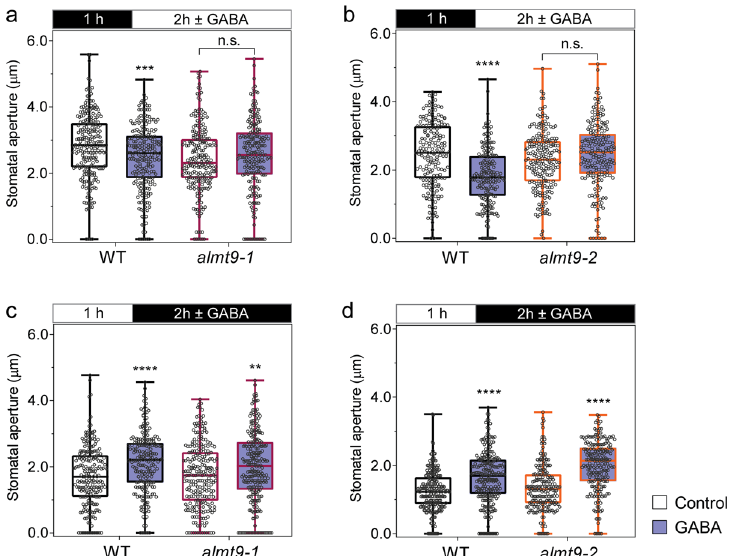
Fig. 7 The loss of ALMT9 abolishes GABA inhibition of stomatal opening but does not affect closure. a – d Arabidopsis WT and almt9 knockout plant stomatal aperture in response to light or dark. Epidermal strips were pre-incubated in stomatal measurement buffer for 1h under dark ( a , b ) or light ( c , d ), followed by 2h in light ( a , b ) or dark ( c , d ) as indicated by black (dark) or white (light) bars above graphs with ±2mM GABA; n = 236 for WT and n = 221 for almt9-1 with control treatment, n = 229 for WT and n = 215 for almt9-1 with GABA treatment ( a ); n = 223 for WT and n = 242 for almt9-1 with control treatment, n = 215 for WT and n = 256 for almt9-1 with GABA treatment ( b ); n = 183 for WT and n = 189 for almt9-2 with control treatment, n = 210 for WT and n = 197 for almt9-2 with GABA treatment ( c ); n = 236 for WT and n = 243 for almt9-2 with control treatment, n = 202 for WT and n = 220 for almt9-2 with GABA treatment ( d ). All data are plotted with box and whiskers plots: whiskers plot represents minimum and maximum values, and box plot represents second quartile, median and third quartile; statistical difference was determined by two-way ANOVA, ** P < 0.01, *** P < 0.001 and **** P < 0.0001. NATURE COMMUNICATIONS| (2021) 12:1952 |https://doi.org/10.1038/s41467-021-21694-3|www.nature.com/naturecommunications